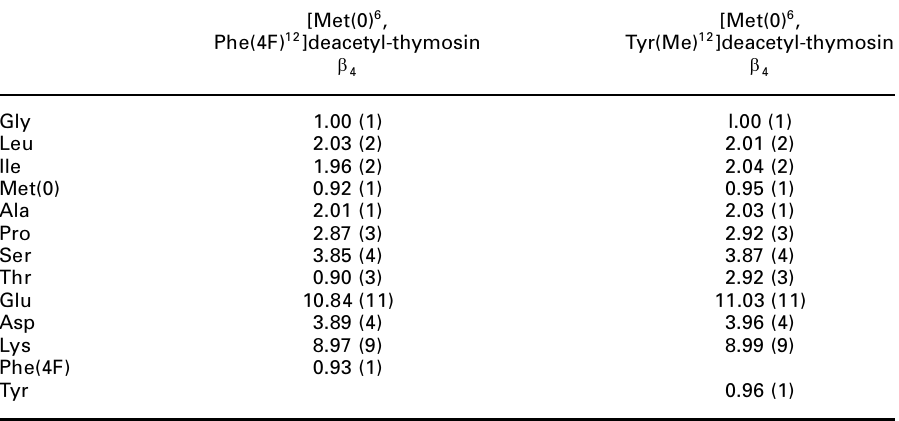
Table 2. Amino acid ratios in 6N HCl hydrolysates of [Met(0) 6 , Phe(4F) 12 ]deacetyl-thymosin b 4 and [Met(0) 6 , Tyr(Me) 12 ]deacetyl-thymosin b 4a